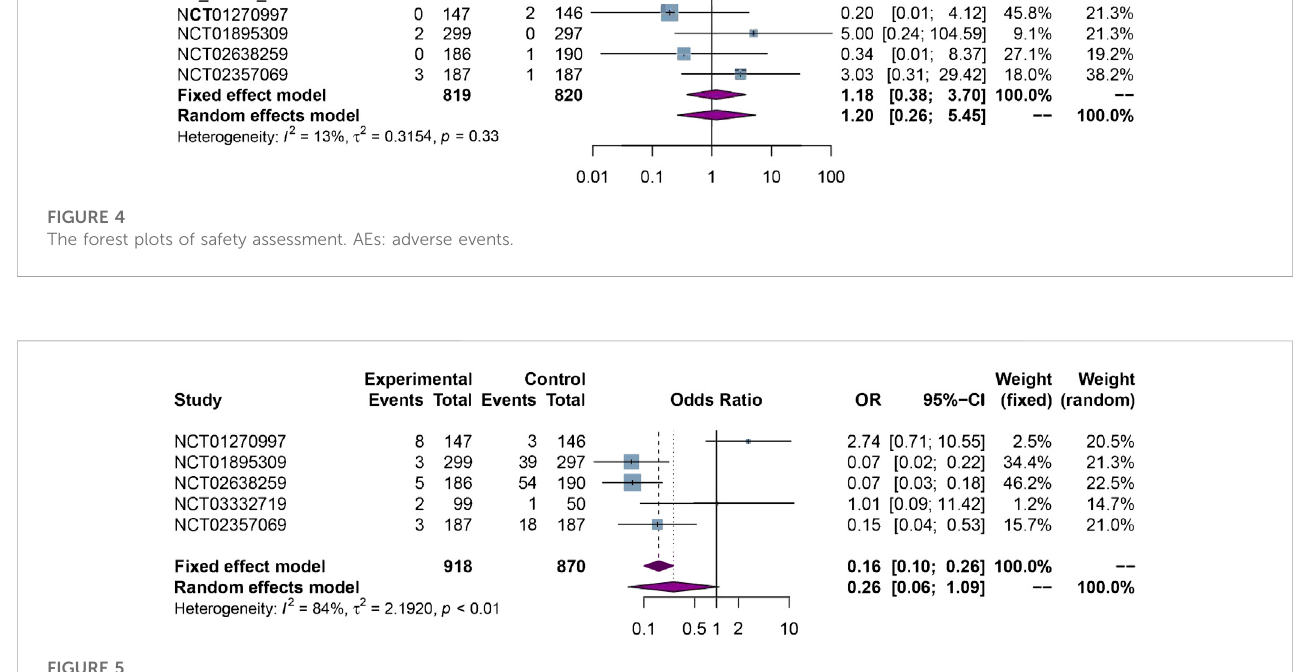
FIGURE 5 The forest plot of immunogenicity